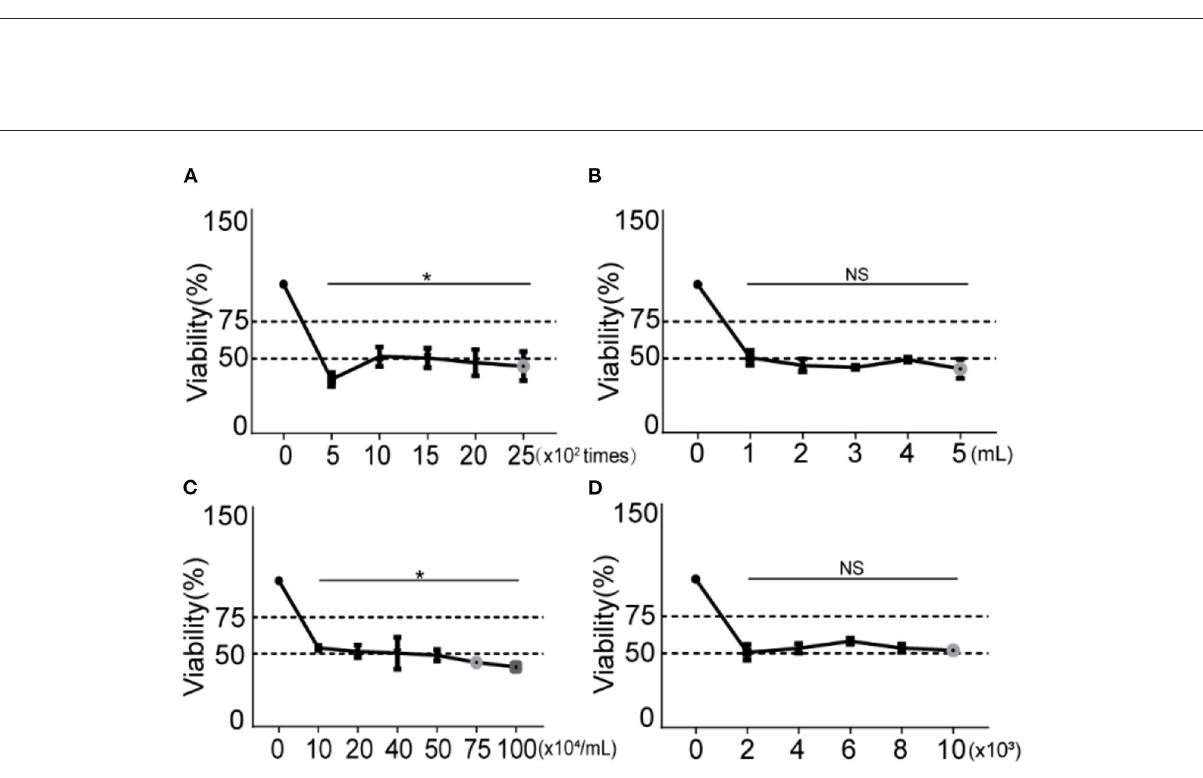
FIGURE3 Changes of cell viability under different blast wave frequencies, modeling volumes, modeling concentrations and cell plating number. (A) Different impulse frequencies are set for comparison. (B) Different modeling volumes are set for comparison. (C) Different modeling concentrations are set for comparison. (D) Different cell plating number is set for comparison. Group 0 represents the control group and data represent mean ± SD; n = 5. * P < 0.05. NS, not significant, P >